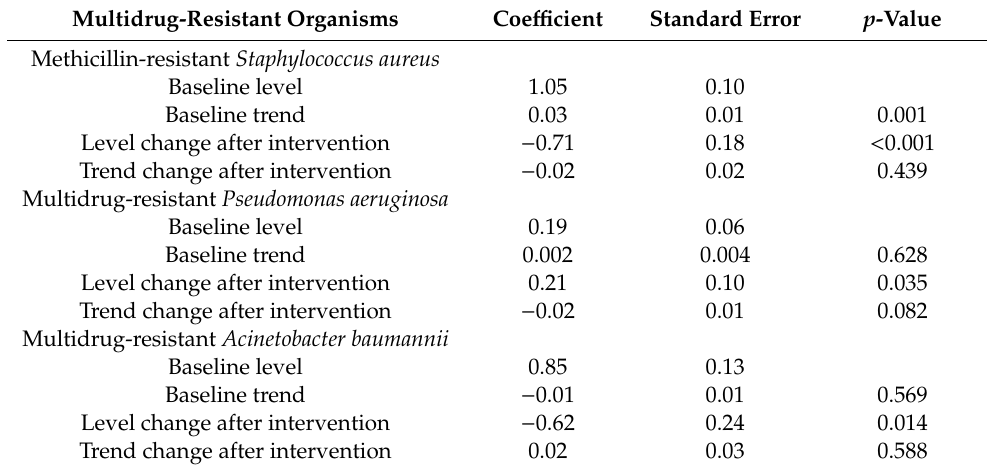
Table 3. The incidence of multidrug-resistant organisms acquisition among patients in the hospital over time using segmented regression